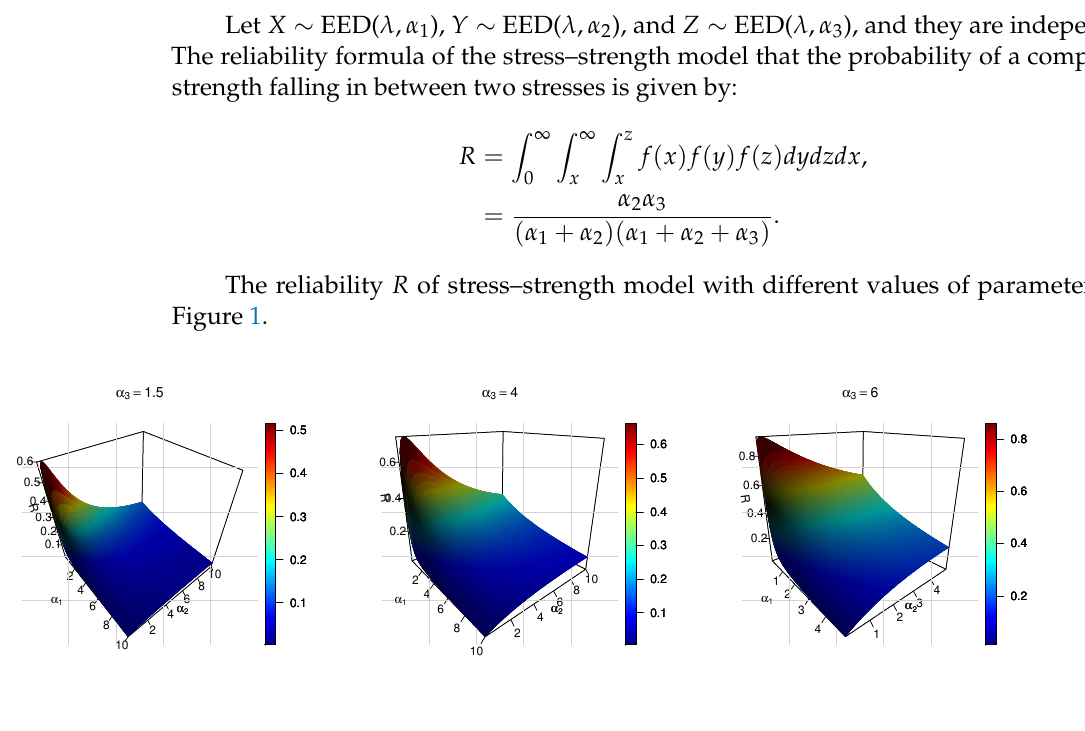
Figure 1. The reliability R of stress–strength model with different values of